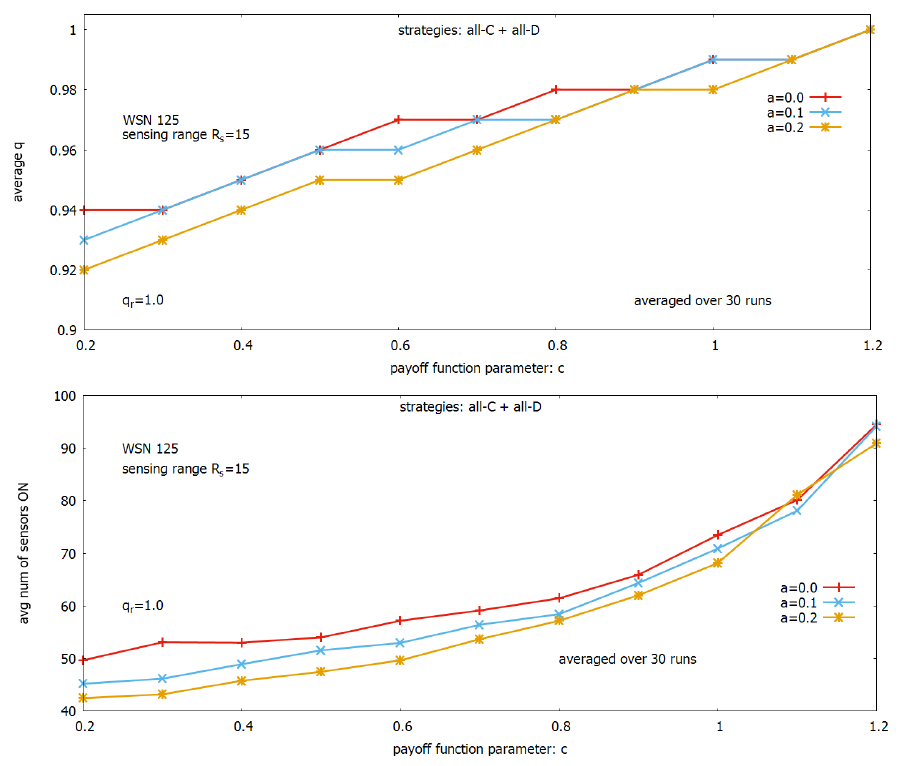
Figure 8. Searching of optimal values for the payoff function parameters a and c : influence of param- eters on coverage q ( upper ), influence of parameters on the number of sensors turned on ( lower ).